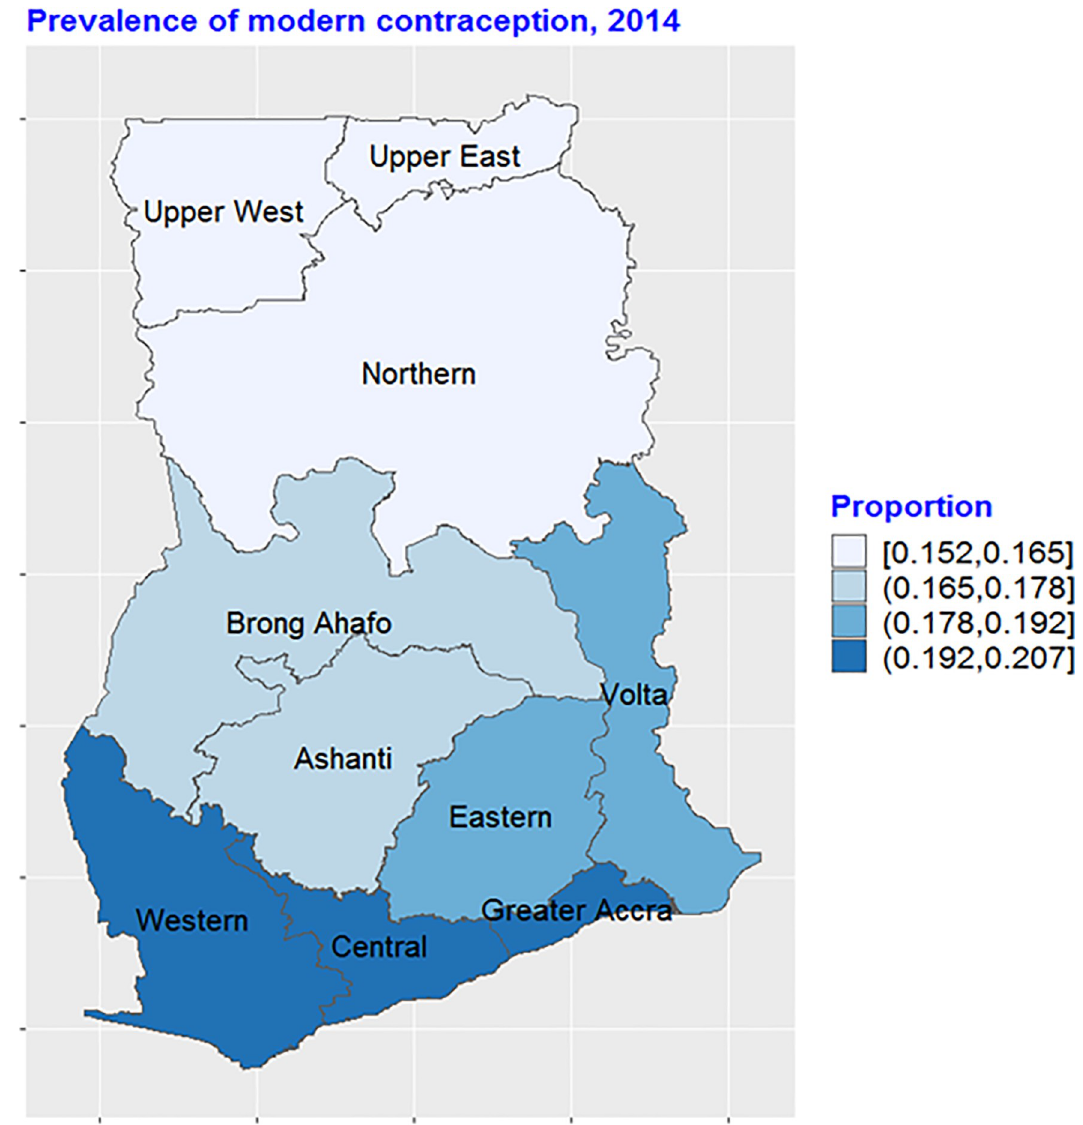
Fig 2. Regional variations in modern contraceptive use in Ghana, 2014. Source: Created by the author based on the 2014 GDHS.